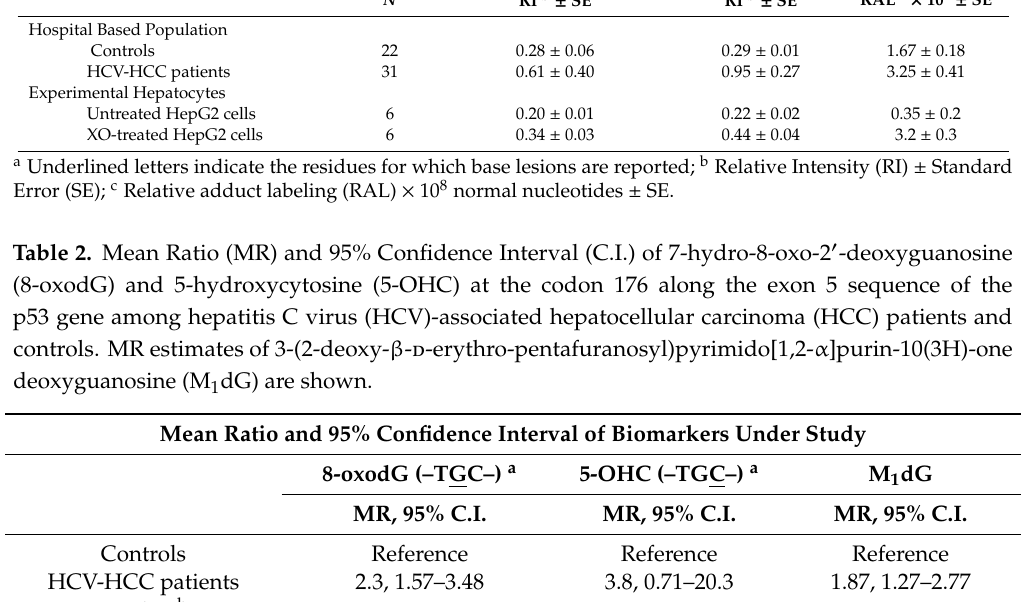
patients and controls (Lanes 1–4, 8, and 9 from the left side), as well as human hepatocytes treated with 0.2 mM xanthine plus 5.0 mU xanthine oxidase (XO)-treated (Lanes 5 and 6). Autoradiograms: Lanes: 1, 3, and 4, HCV-HCC patients; Lanes 2, 8, and 9, controls; Lane 5, XO treatment; Line 6, no XO treatment; Lanes 7 and 10 molecular weight; Lanes 11–14, sequencing ladders. Heavy modified –G– a Underlined letters indicate the residues for which lesions are reported; b p -values referred to comparison with the reference level after correction for age and gender. and –C– positions at codon 176 are labeled.